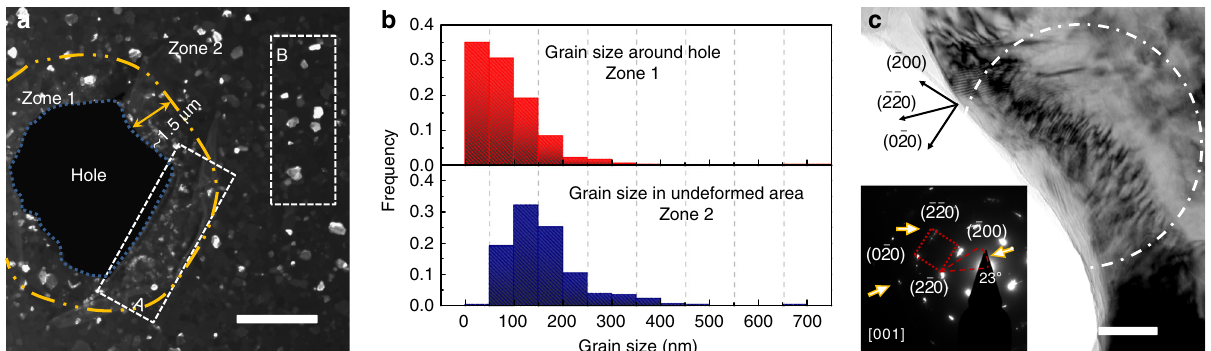
Fig. 4 Grain fragmentation and coarsening near the perforations. a A dark- fi eld TEM image of the grains near a perforation. The grains in area A in zone 1 (within the 1.5 μ m wide impact zone) are typically smaller than those in area B in zone 2 (further away from the impact zone), indicating grain fragmentation during projectile impact. The yellow dash-dot line delineates the boundary between zone 1 (highly impacted zone) and zone 2 (less deformed area). Scale bar, 2 µ m. b The statistical distribution of grain sizes in zone 1 and 2. c A low magni fi cation bright fi eld TEM micrograph showing the morphology of an elongated grain containing a high density of dislocations adjacent to a hole. The length of the grain is ~300 nm, and its width is ~70 nm. The inserted diffraction pattern shows the slightly axisymmetric elongated {220} diffraction spots examined along < 100 > diffraction zone axis, indicating subgrain rotation within the grain. Scale bar,